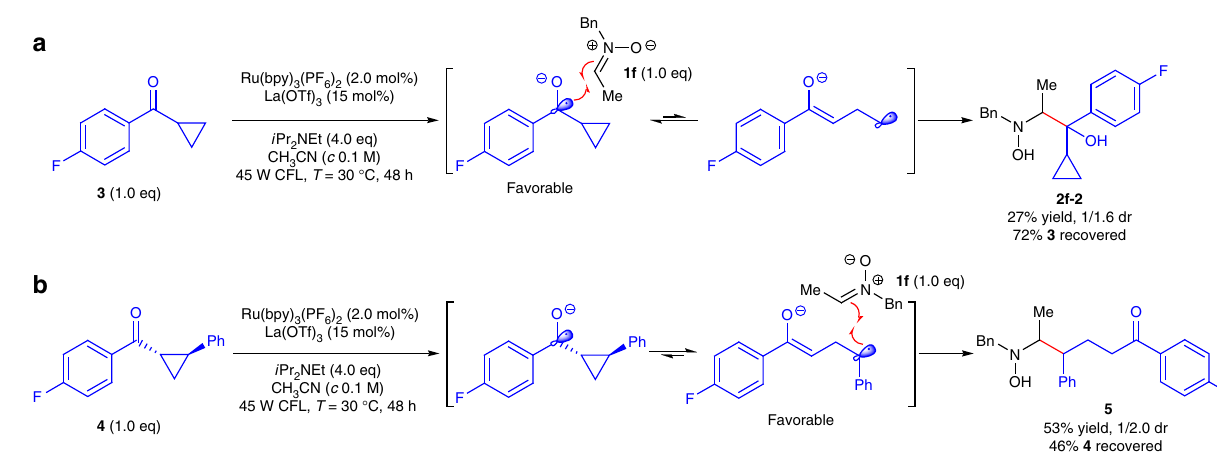
Fig. 2 Radical clock reactions. a The normal cross-coupling was observed without ring opening product from ketone 3 . b The radical clock generated from well-designed radical clock precursor 4 was rearranged and added to nitrone